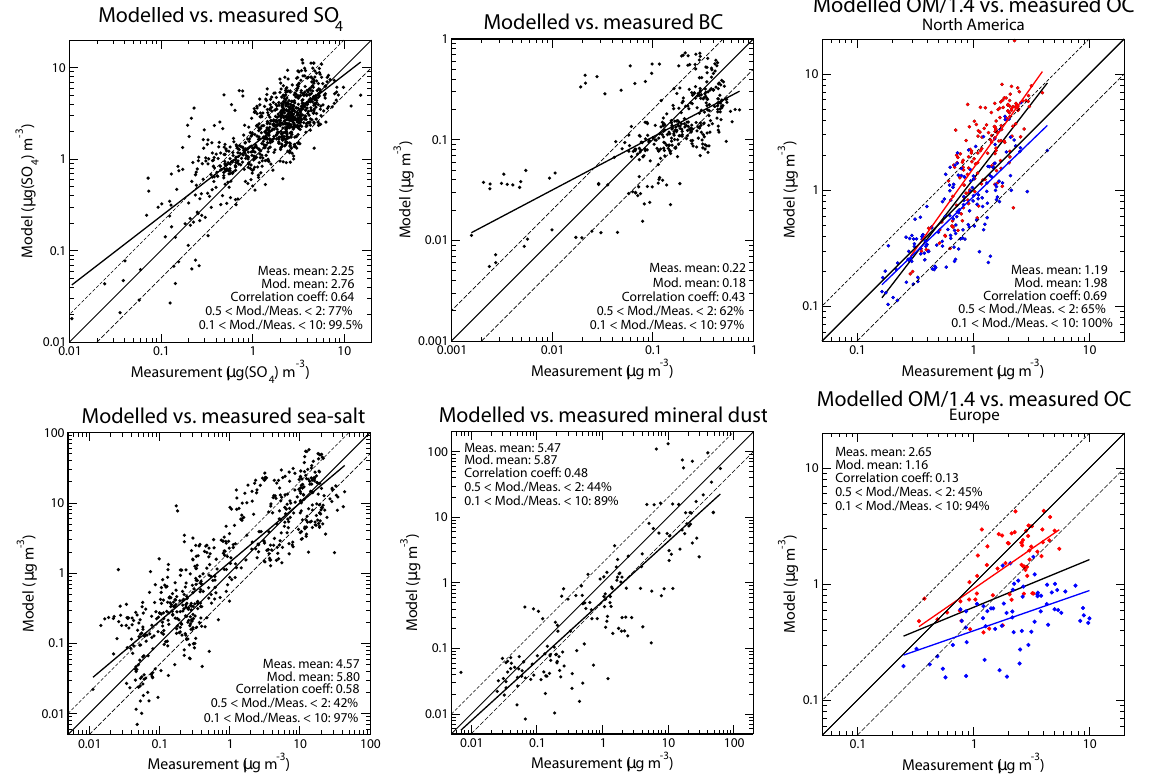
Fig. 4. Modeled versus measured monthly mean ground-level mass concentrations of selected aerosols. The measurements, all from 1996– 2002, are made available through the AeroCom project from the AEROCE, AIRMON, EMEP, GAW and IMPROVE measurements networks. The European (EMEP) data are from year 2002, however, and OC data are here given as PM 10 , while the North American OC data are given as PM 2 . 5 . The European OC measurements have therefore here been scaled by a factor 0.72, to account for the difference between PM 2 . 5 and PM 10 . The OM data have been split into summer (April–September, red) and winter (October–March, blue). The straight diagonal solid and dashed lines define identical results and a factor 2 difference between the modeled and measured data, respectively. The bold solid lines are regression lines for summer (red), winter (blue) and the full year